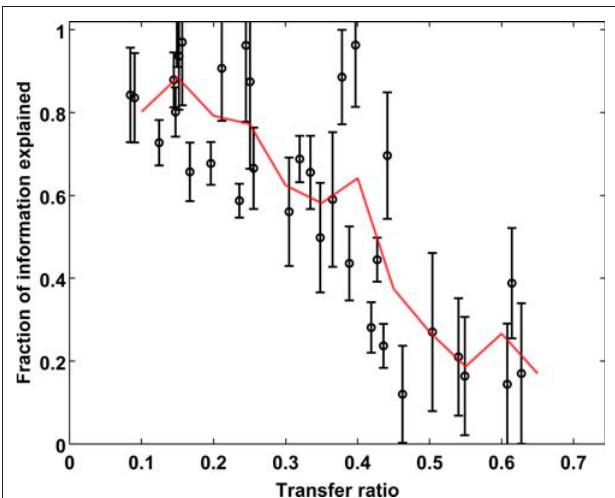
FIGURE 5 | Performance of the pair model. The percentage of LGN single spike information captured by the model is plotted as a function of transfer ratio. The ability of this simplistic model to capture the essential behavior of the LGN declines with increasing transfer ratio, and is a result of the fact that at transfer ratios above 0.5 it is impossible for all the LGN spikes to come from pairs of RGC spikes. The dashed line represents the (binned) average of the points as a function of transfer